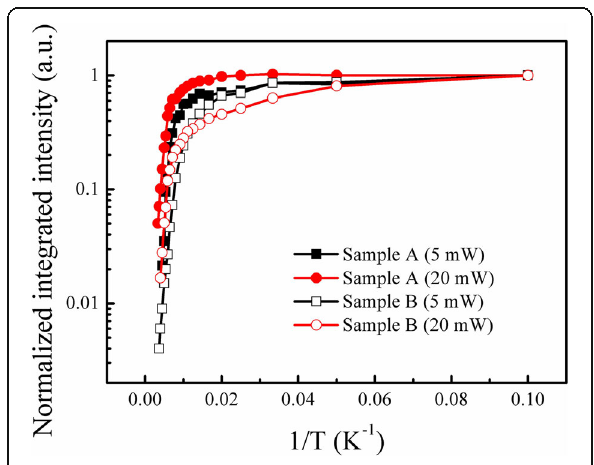
Fig. 7 The integrated intensity extracted from PL spectra of both samples at a temperature range of 10 – 300 K, measured under excitation powers of 5 mW and 20